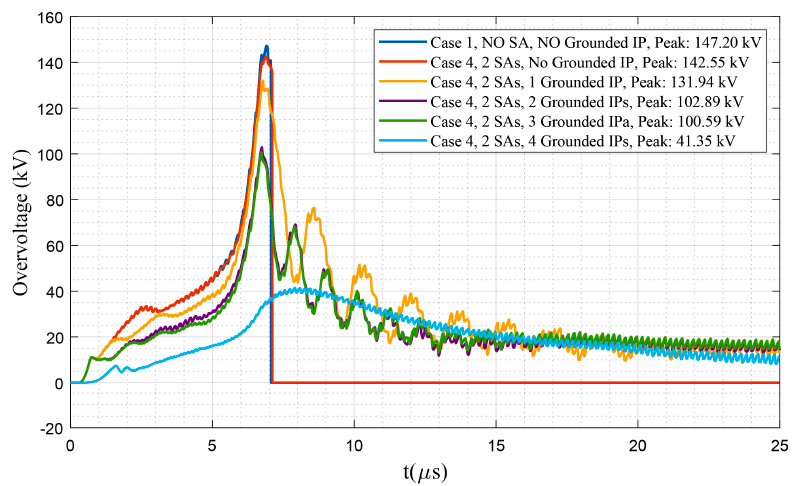
Figure 31. Comparison among the overvoltage stress at terminal c of the transformer mounted at pole #36 under different grounding densities; Network with dry poles considering two surge arrester protected transformers and under a lightning strike on pole #35.